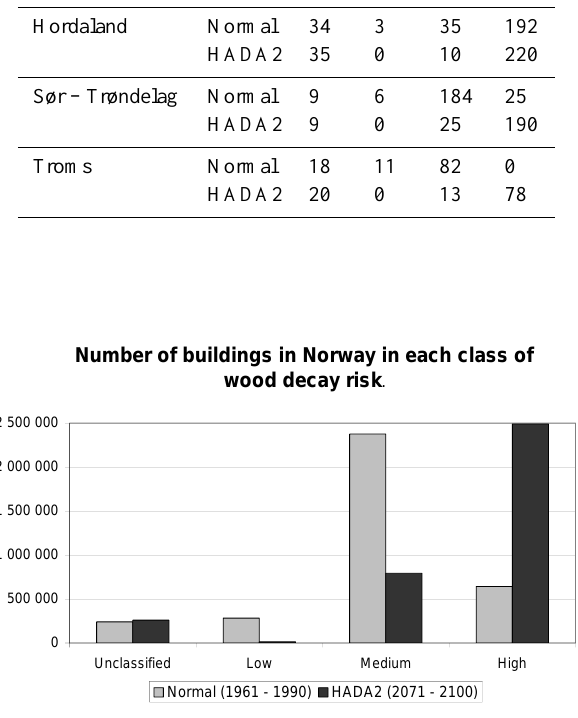
Figure 3. Number of buildings in Norway in normal climate and future climate according to scenario A2. Normal climate in grey and future climate in